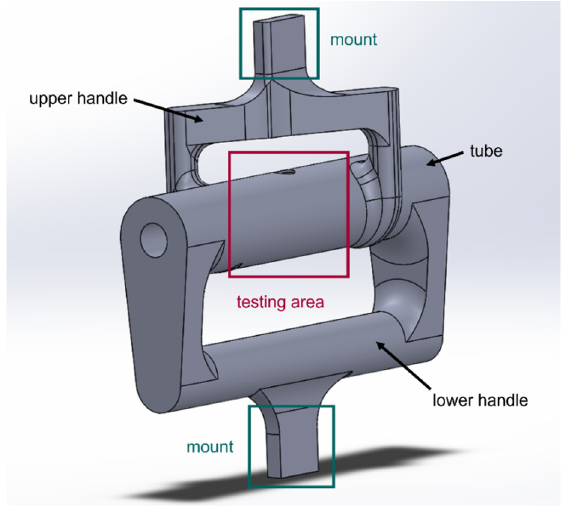
Figure 7. One-piece combined loading tubular specimen design.